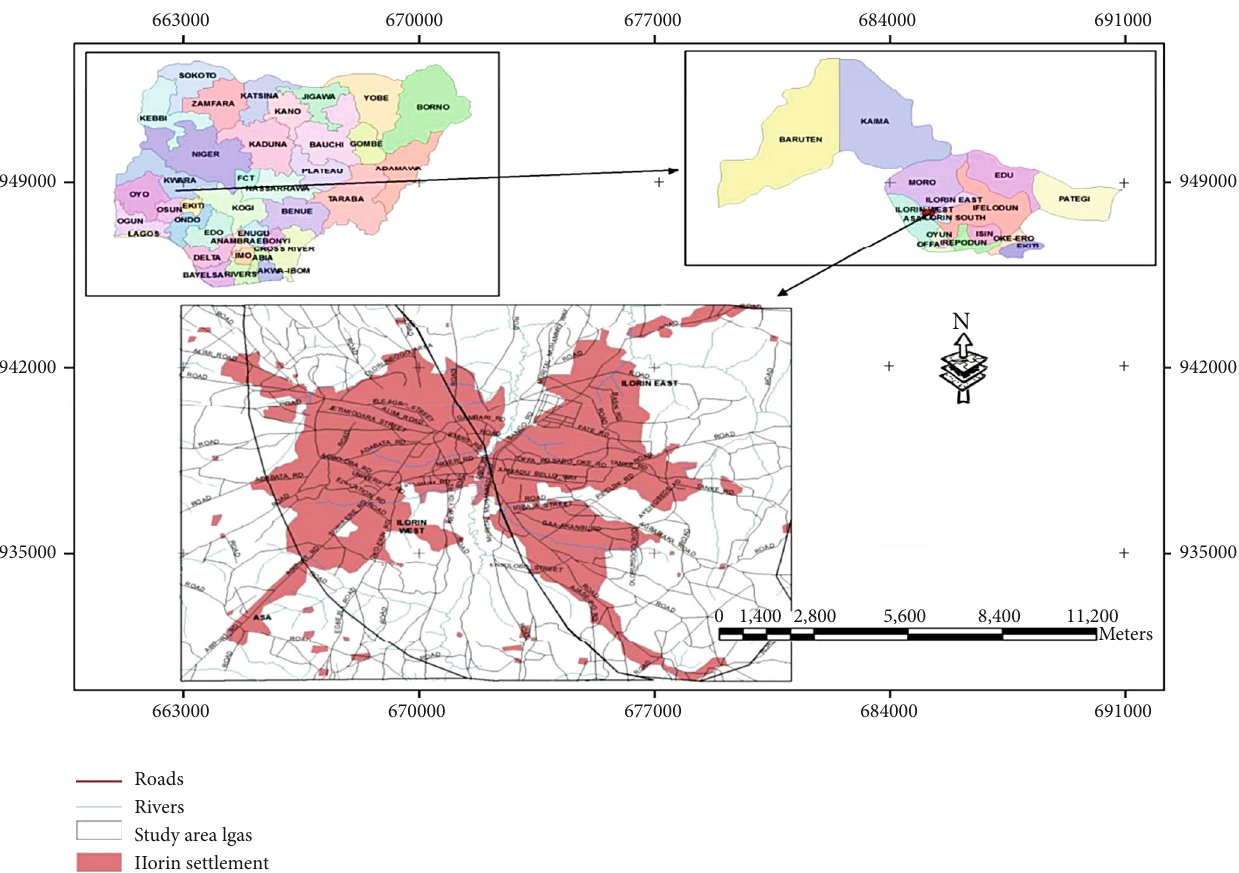
Figure 1: Map of the study area. Sources: Dooyum [15]. Isolation and antibiograms of Staphylococcus aureus of fresh cow milk and fried cheese from three local government units of